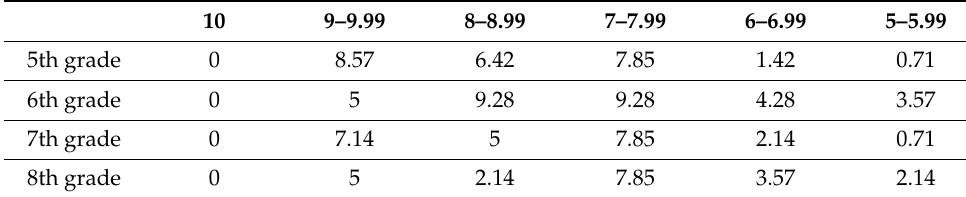
Table 5. Averages in first semester without COVID pandemic, face-to-face courses